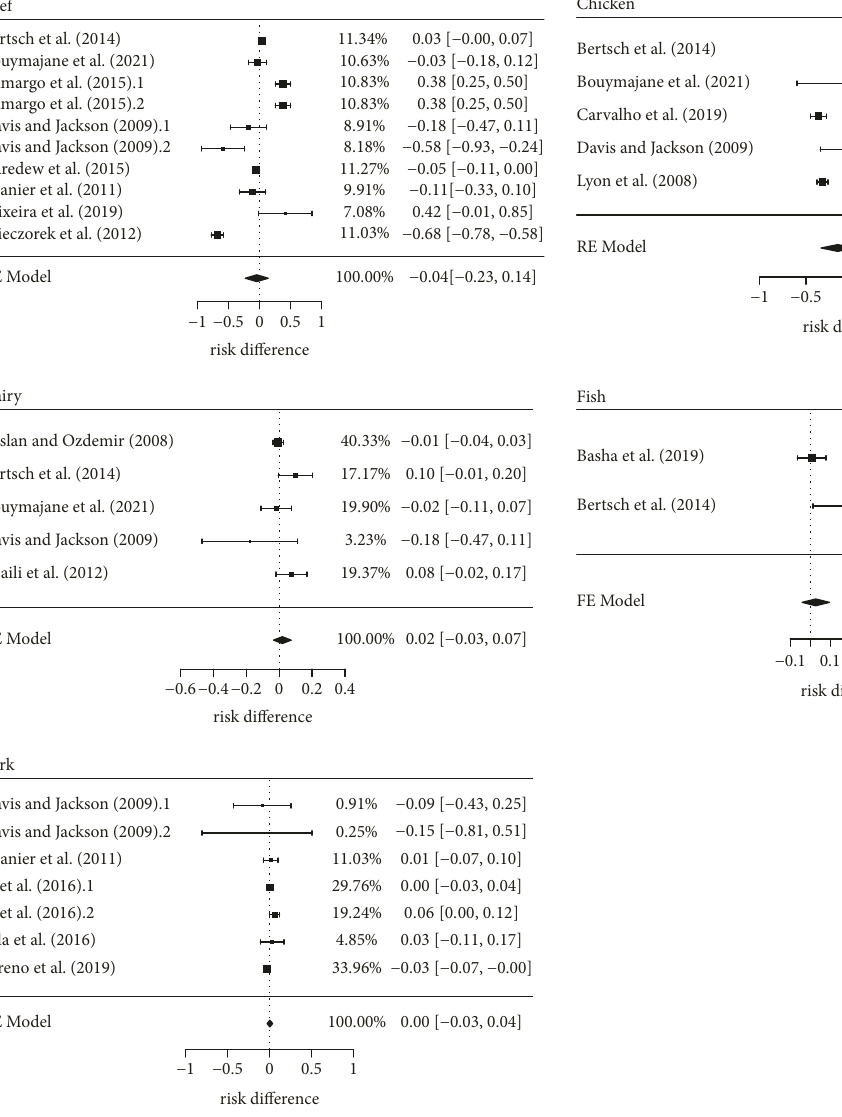
Figure 6: Risk difference of antimicrobial resistance to first- and second-line drugs in Listeria monocytogenes by animal production chain. Table 3: Estimates and main statistics of the risk difference of antimicrobial resistance in Listeria monocytogenes by animal production